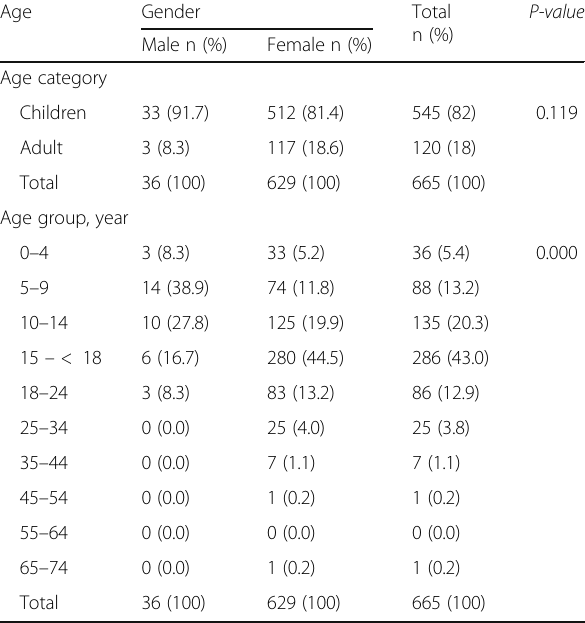
Table 2 Association of age category and age group with gender in sexual violence cases in Pekanbaru, Indonesia (n =